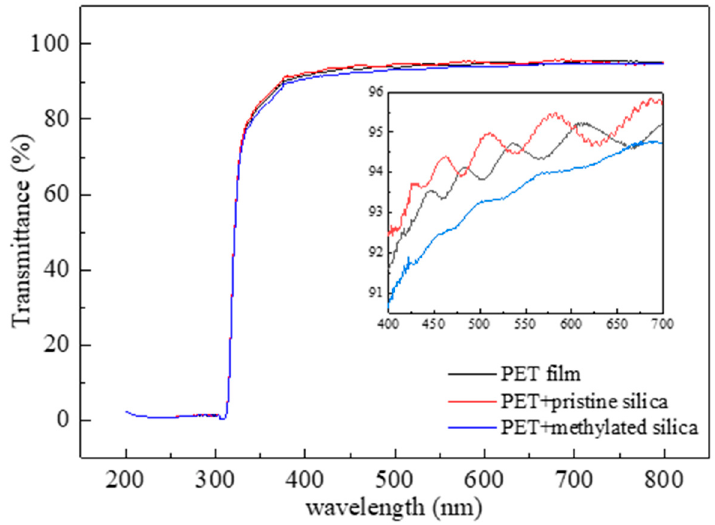
Figure 4. Transmittance of the coated PET films with pristine and methylated silica sol.